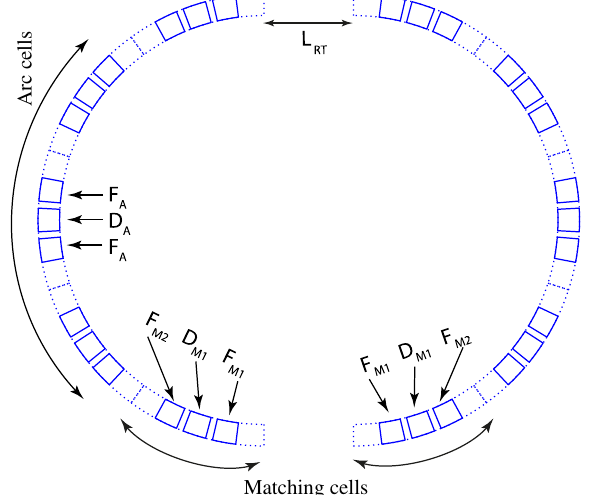
FIG. 11. Schematic of the racetrack cells showing the long magnet-free straights L RT and the two types of cell: arc and matching. Five families of magnets are shown, all have the same field index k and together these make up the six free parameters used in the optimization. All of the six arc cells have just one type of F and one type of D magnet.